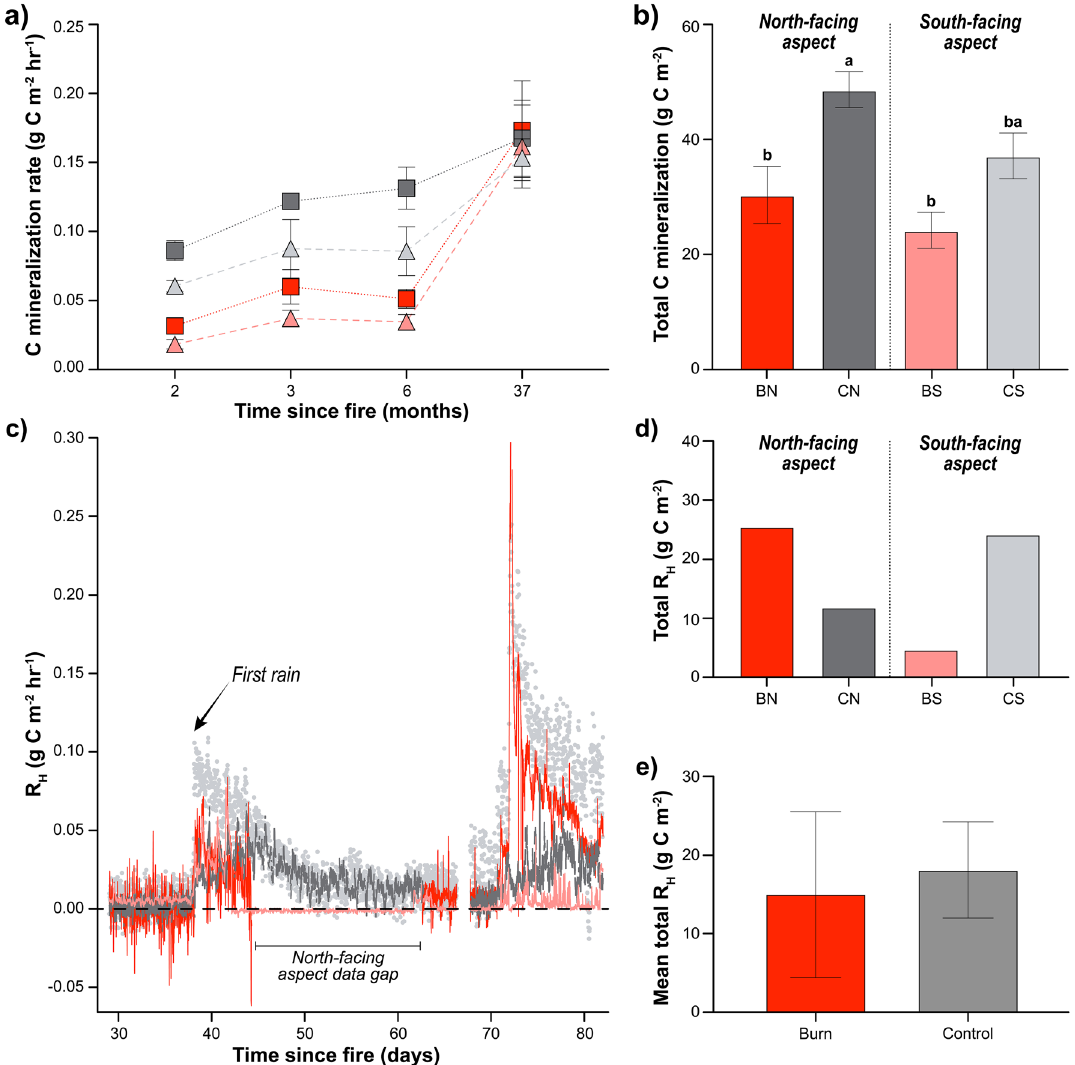
Figure 5. Respiration on burned aspects was reduced relative to controls in both lab and field measurements. ( a ) Soil carbon (C) mineralization rates with time (months) since fire on burned (red and pink) and control (dark and light gray) for north- (squares) and south-facing aspects (triangles) 2–37 months after fire, ( b ) total C mineralization that occurred during this period, ( c ) respiratory fluxes (R H ) with reduced and even negative fluxes immediately after fire in September (~ 30 days post-fire) on the burned north-facing aspect (red line), ( d ) total losses from each site showing variable losses from different burned and control aspects, and ( e ) average total fluxes from burned and control aspects were not significantly different owing to difference in